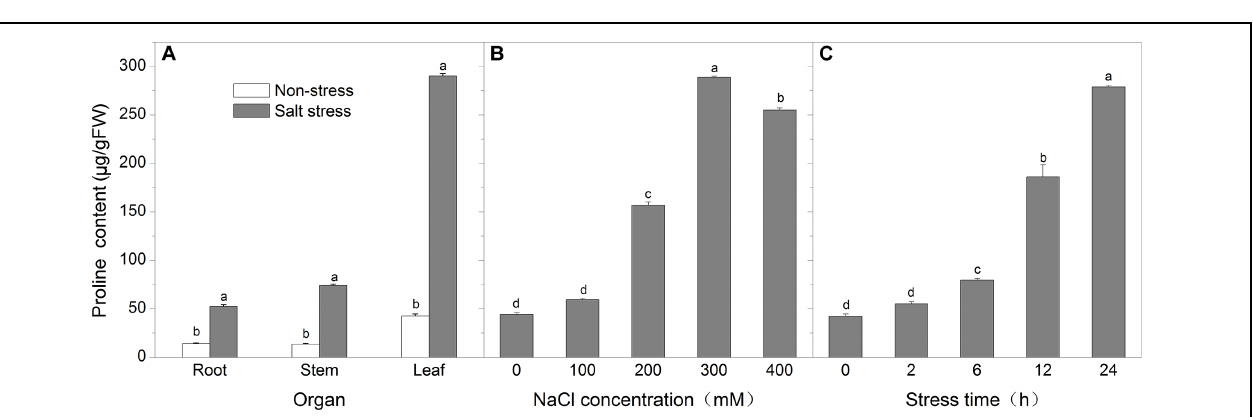
FIGURE 2 | The changes of free proline content. (A) The proline content in roots, stems, and leaves under non-stress and 300 mM NaCl for 24 h; (B) The proline content in leaves under salt concentration gradient treatments for 24 h; (C) The proline content in leaves under time-course treatments with 300 mM NaCl. Each data point represents the average of three replications and the error bars represents standard deviation based on three replications. Data was analyzed by analysis of variance (ANOVA), followed by least significant difference (LSD) tests.